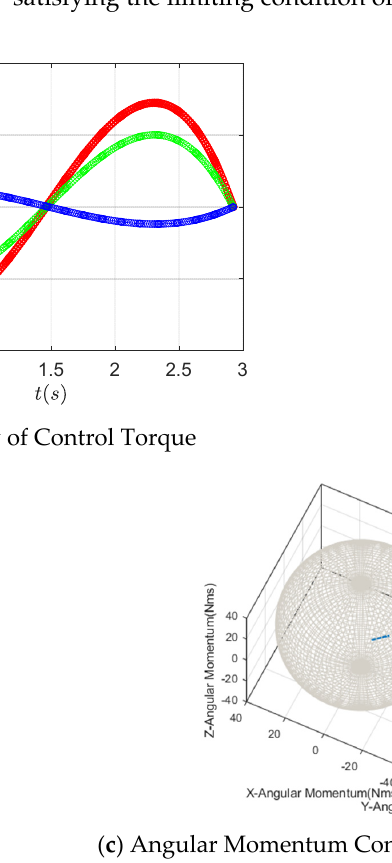
Figure 17. History of control for retargeting control optimization.